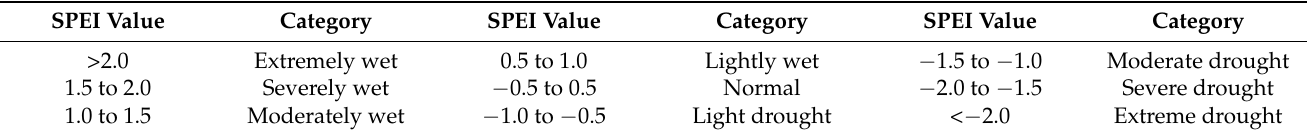
Table 2. Categorization according to the SPEI values.